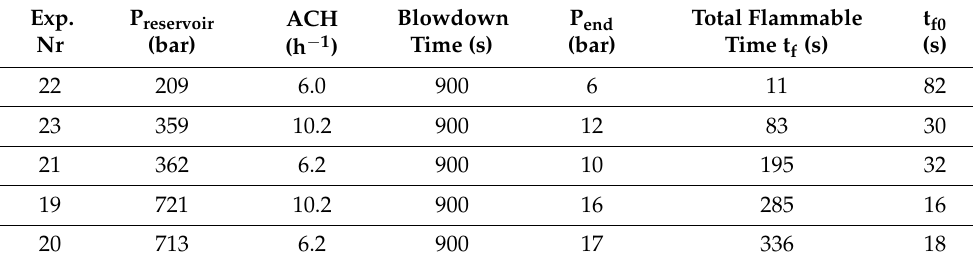
Table 3. The flammable time during blowdown